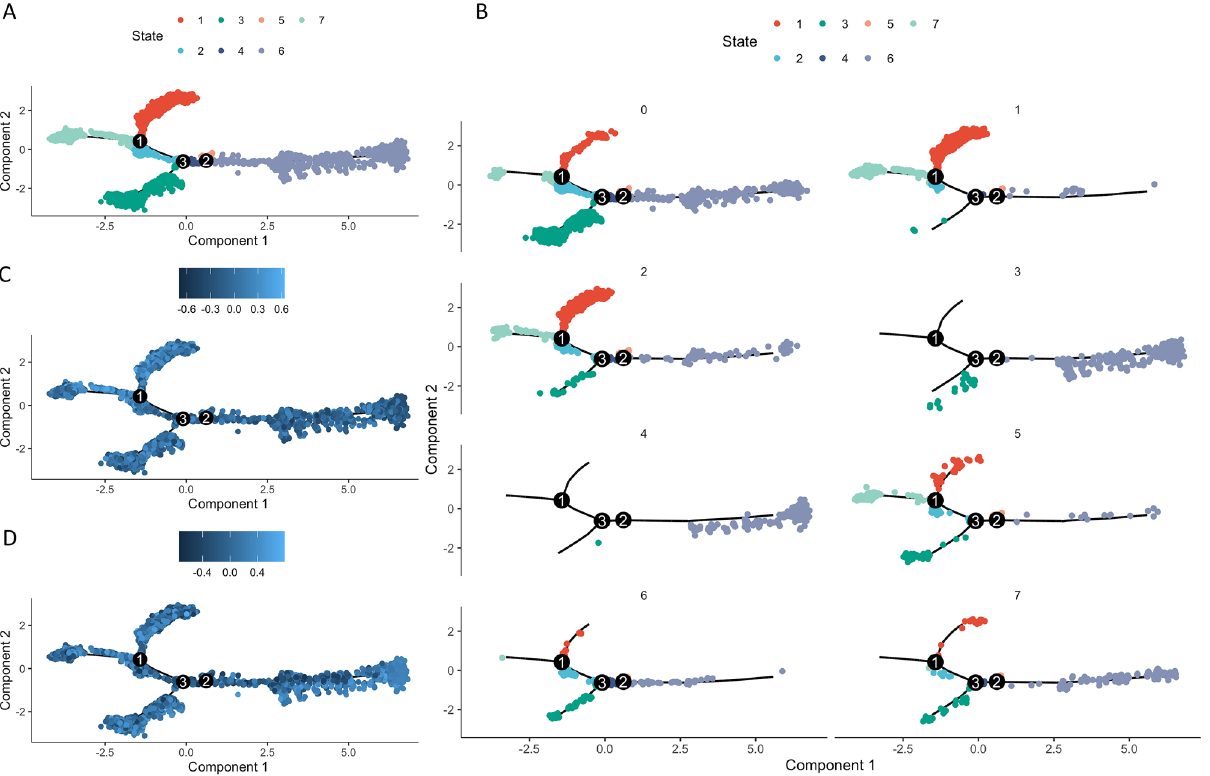
Figure 6. Cell progression pseudotime from Monocle analysis ( A ), methylation scores along the imputed pseudotime ( B ), demethylation scores along imputed pseudotime ( C ), and cell progression pseudotime according to Seurat cluster ( D